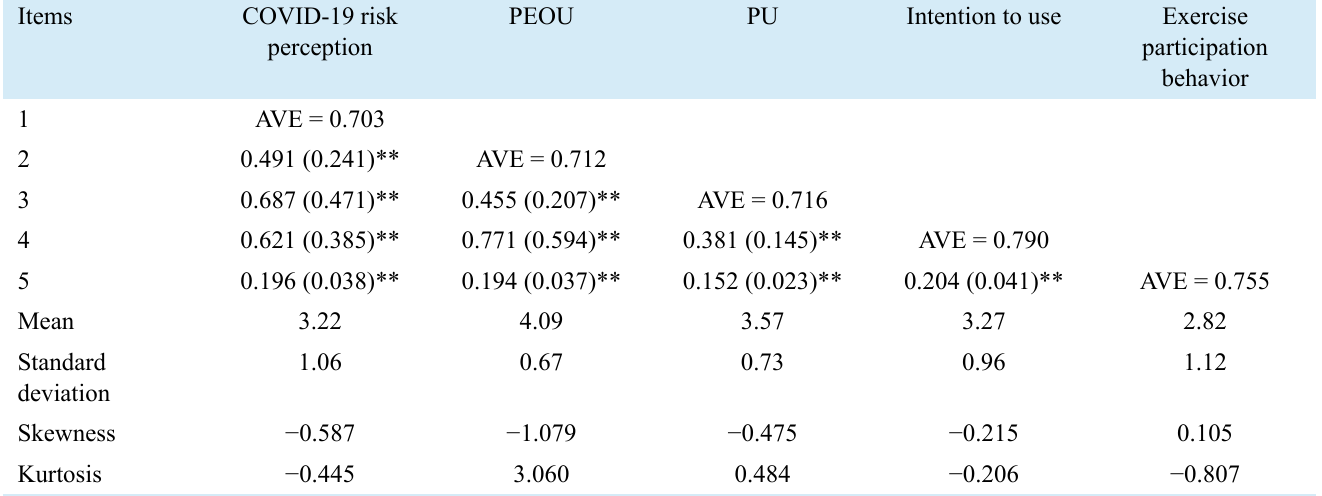
TABLE 3. Results of Pearson’s correlation and normality